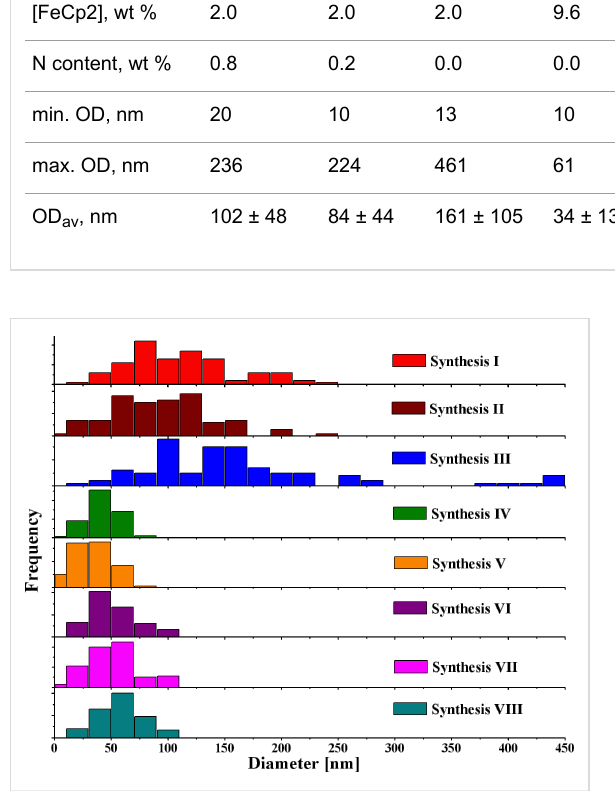
Figure 4: Histograms of the outer diameters of N-CNTs from Syntheses I–VIII .